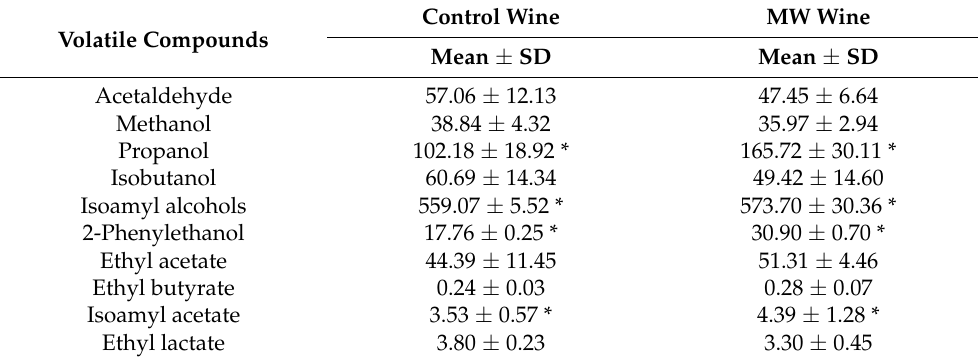
Table 4. Major volatile composition (mg/L) of control wines and wines from microwave